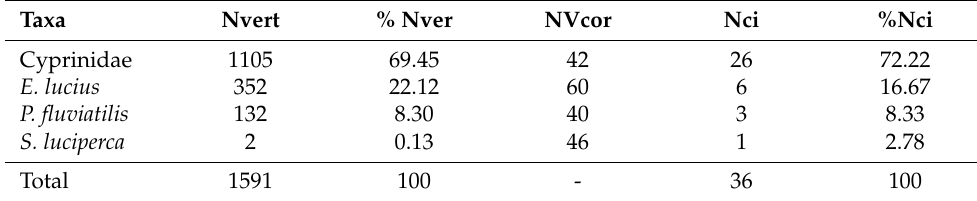
Table 5. Relative abundance of fish taxa represented in Borsodiv á nka 2020. Nvert, number of vertebrae recovered from the assemblage; NVcor, corrected expected number of vertebrae; Nci, number (estimated) of captured